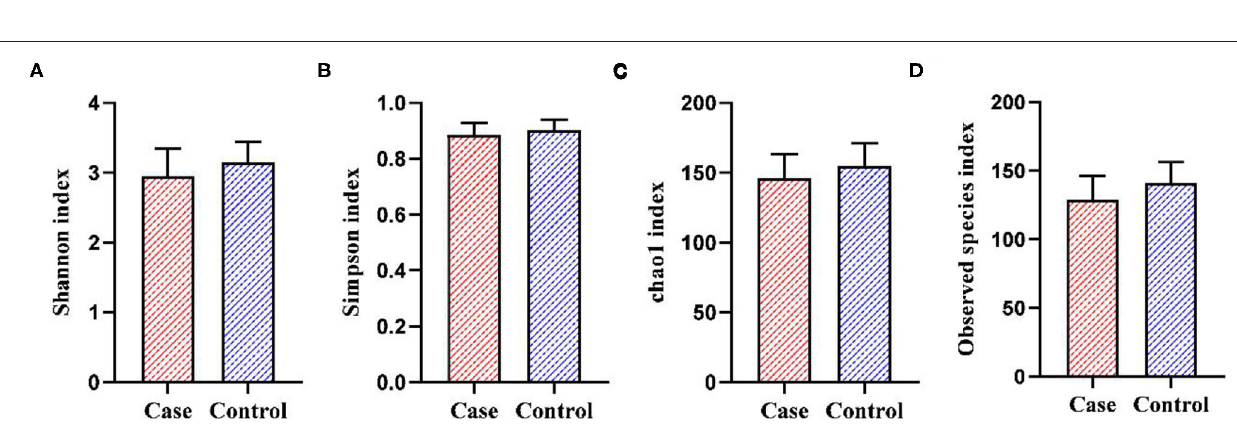
was positively correlated with albumin and dietary intakes of energy, vitamin C, and vitamin E in patients with HDP ( Figure 7